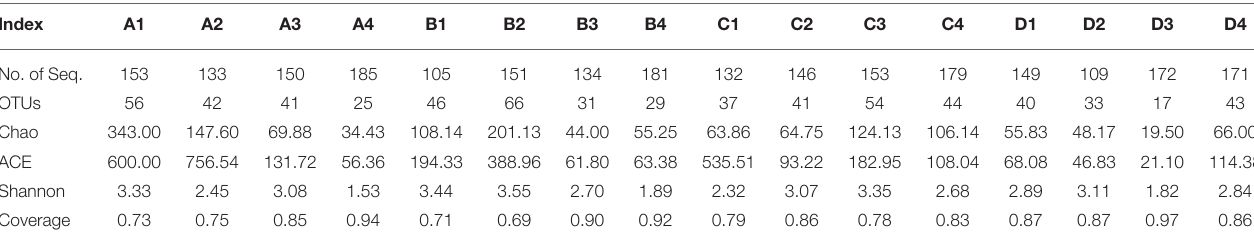
TABLE 1 | Number of sequences and OTUs (97%) and diversity estimates of the Actinobacteria libraries in P . lutea and in the ambient